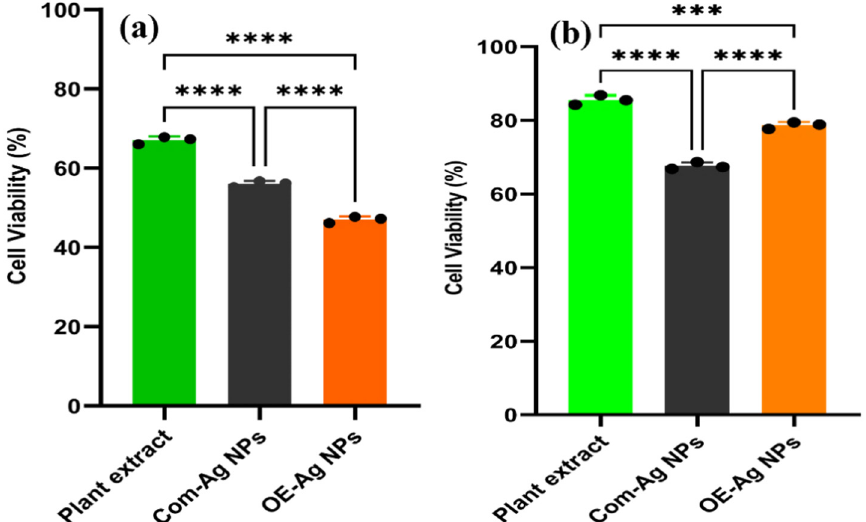
Figure 8. ( a ) Cytotoxic propensity against MCF-7 carcinoma cells and ( b ) biocompatibility against hMSC cells after incubation for 24 h with OE-Ag NPs, plant leaf extract and Com-Ag NPs (**** p < 0.0001, *** p <